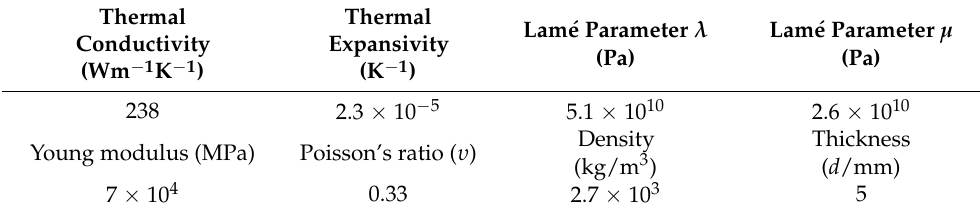
Figure 2. Geometry of the FEM model. Table 1. Physical parameters.